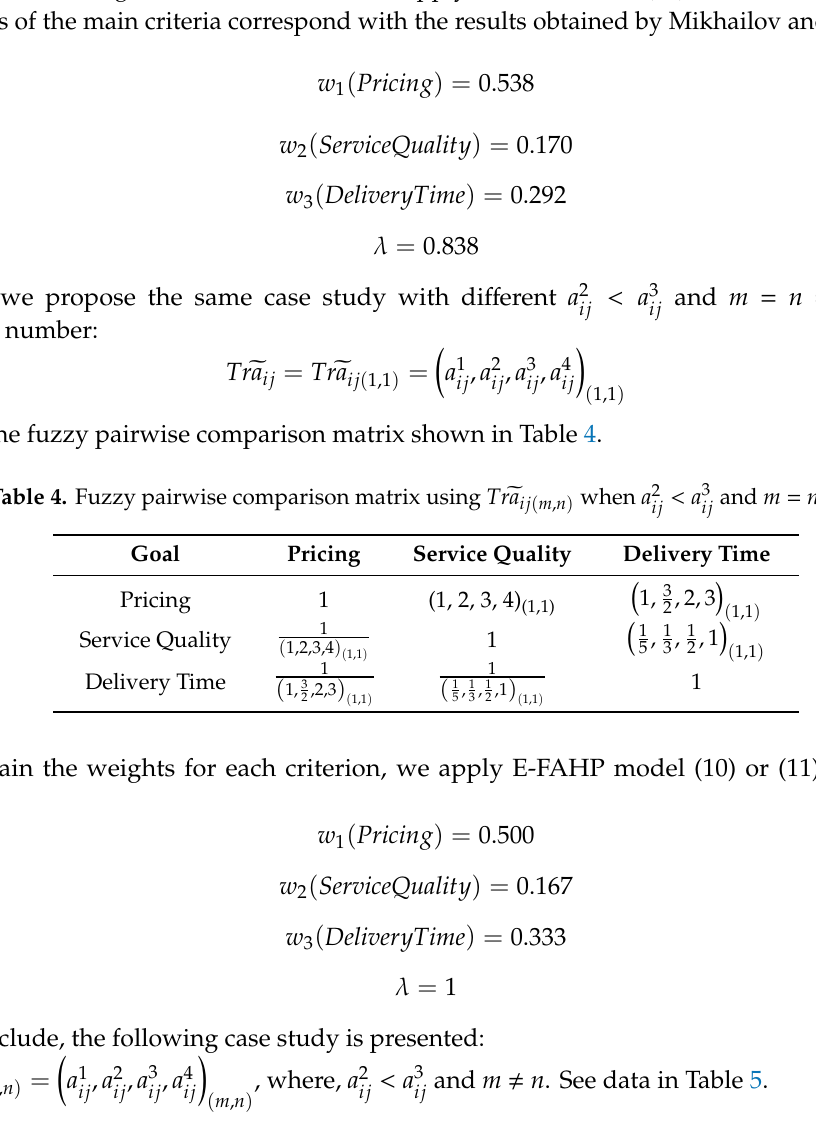
Table 5. Fuzzy pairwise comparison matrix using Tr (cid:101) a ij ( m , n ) when m (cid:44) n and a 2 Goal